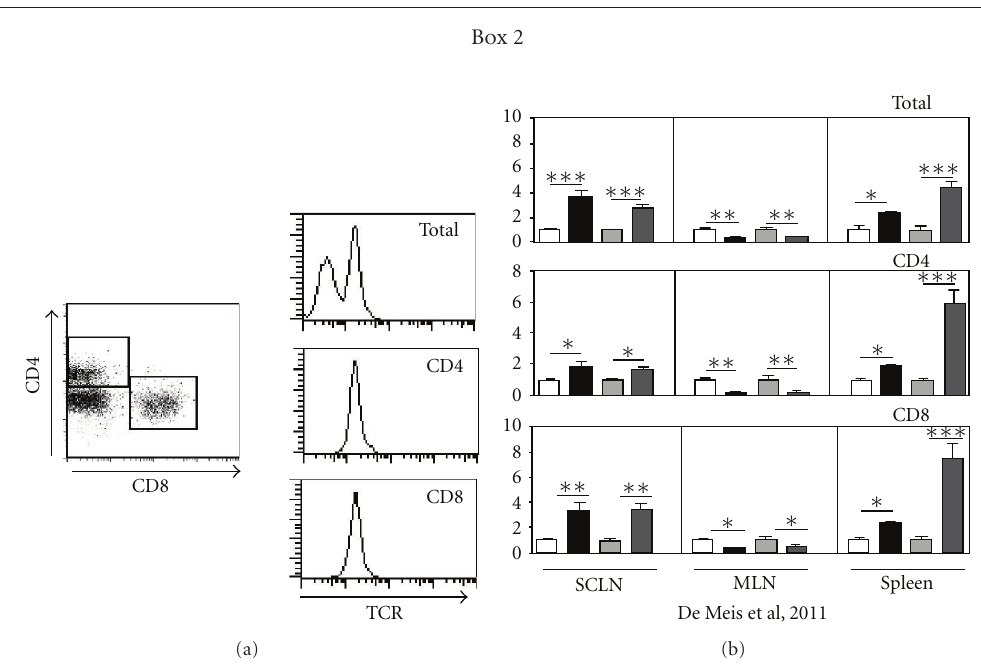
Figure 3: Thymectomy modulates splenic cell numbers during acute Trypanosoma cruzi infection. Mice were thymectomized and, six days later, were infected intraperitoneally by the Tulahu´en strain of T. cruzi . Animals were killed at 19 days postinfection, and subcutaneous (SCLN), mesenteric (MLN), lymph nodes and spleen cell numbers were evaluated. (a) Representative data demonstrating TCR expression in CD4 and CD8 T cells in SCLN, MLN, and spleen, analyzed by flow cytometry. (b) Data show fold change of 6–8 animals/group where (white rectangle) represents sham-operated control, (black rectangle) sham-operated infected, (light grey rectangle) thymectomized control, and (dark grey rectangle) thymectomized infected mice. Results were representative of three di ff erent experiments and were expressed as mean ± standard deviation, ns: not significant, ∗ P < 0 . 05, ∗∗ P < 0 . 01, and ∗∗∗ P < 0 . 001, after comparison by One Way